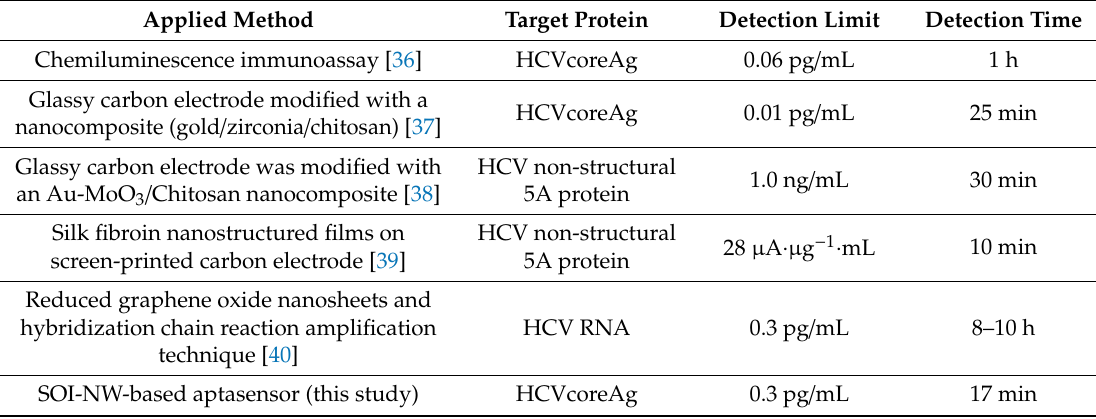
Table 1. Analytical characteristics of di ff erent methods for hepatitis C virus (HCV)